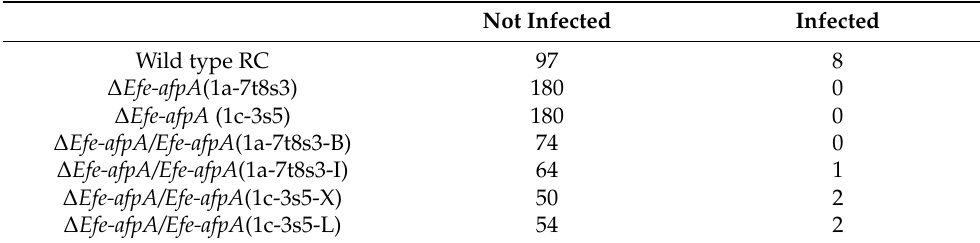
Table 1. Results of inoculating strong creeping red fescue ( Festuca rubra subsp. rubra ) seedlings with the Epichloë festucae wild type Rose City (RC) isolate, the two Δ Efe-afpA knockout isolates, and the four Δ Efe-afpA/Efe-afpA complemented isolates.